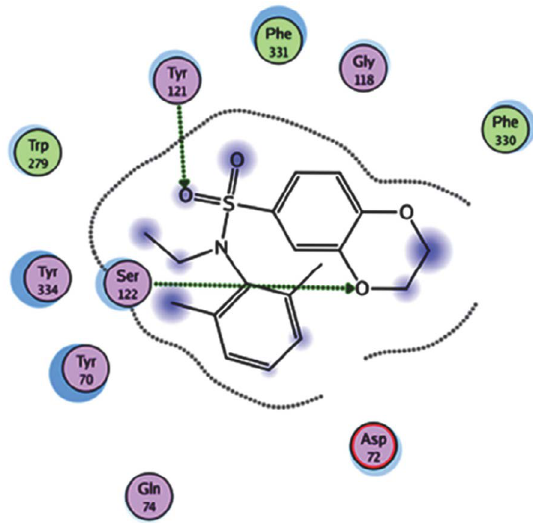
Figure 5: 2D image of compound N -(2,6-dimethylphe- nyl)- N -ethyl-2,3-dihydro- benzo[1,4]dioxine-6-sulfonamide ( 7d ) against